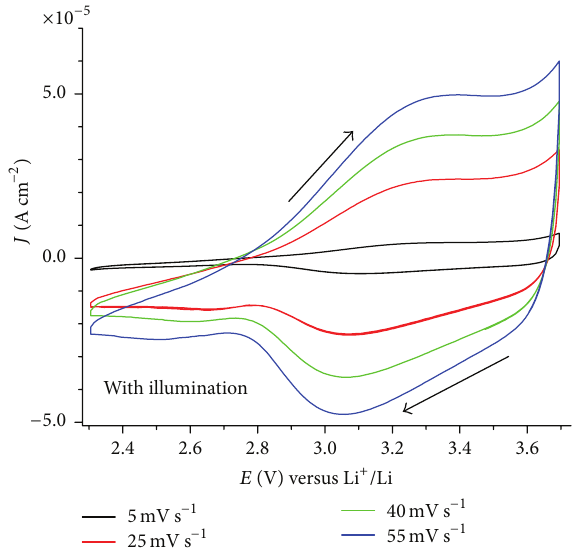
Figure 20: Cyclic voltammograms of ERY-sensitized CS NiO spray- deposited onto ITO. All voltammograms have been under irradia- Figure 22: Comparison of the cyclic voltammograms of ERY- : 28.6 Wcm −2 ). tion with white light (light source: halogen lamp; 𝐼 sensitized CS NiO coating (thickness: 0.3 𝜇 m) in the dark and under in Scan rates have been varied between 5 and 55 mVs −1 . The applied illumination with the white light produced by a halogen lamp ( 𝐼 potential varied within the potential range of bare CS NiO oxidation = 28.6 Wcm −2 ). The applied potential was scanned at the rate of indarkconditions(Figures6and9).Counterelectrode:Li;reference 5 mV s −1 . Electrolyte composition as in Figure 1. Arrows indicate redox couple: Li + /Li. Electrolyte composition as in Figure 1. Arrows the direction of potential scan. Profiles have been extracted from indicate the verse of potential scan. Figure 19 (dark conditions) and Figure 20 (illuminated